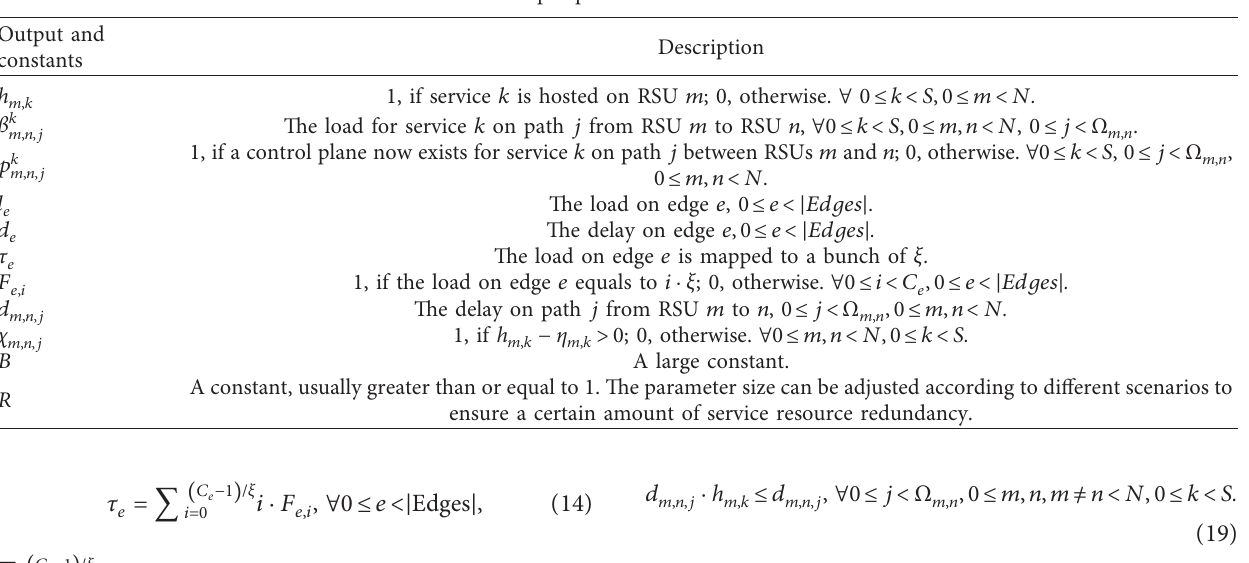
Table 2: Output parameters and